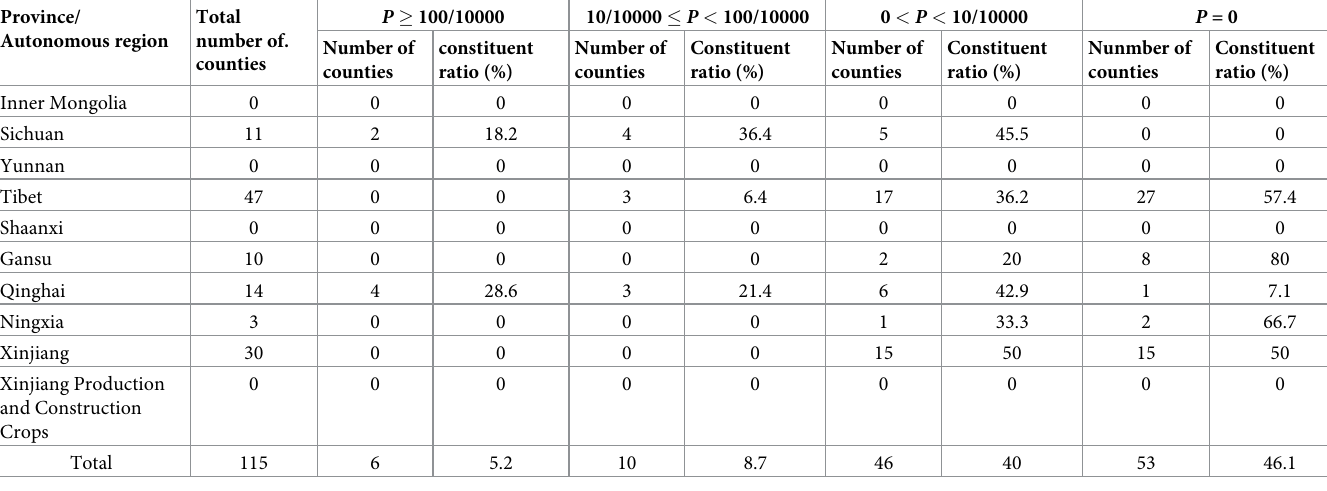
Table 4. Classification of the prevalence rate for human AE in China, 2018. Province/ Total Autonomous region number of.